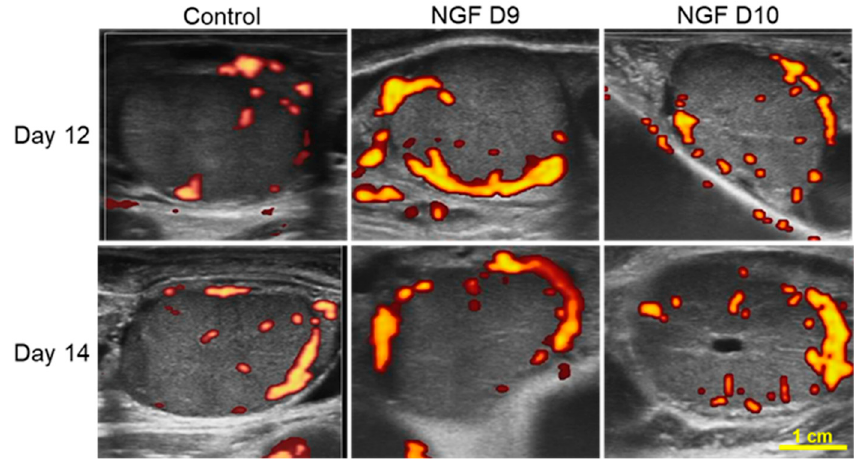
Figure 5. Representative corpora lutea (CL) obtained with Power Doppler ultrasonography, showing the maximum blood flow areas in heifers over the follow-up days.